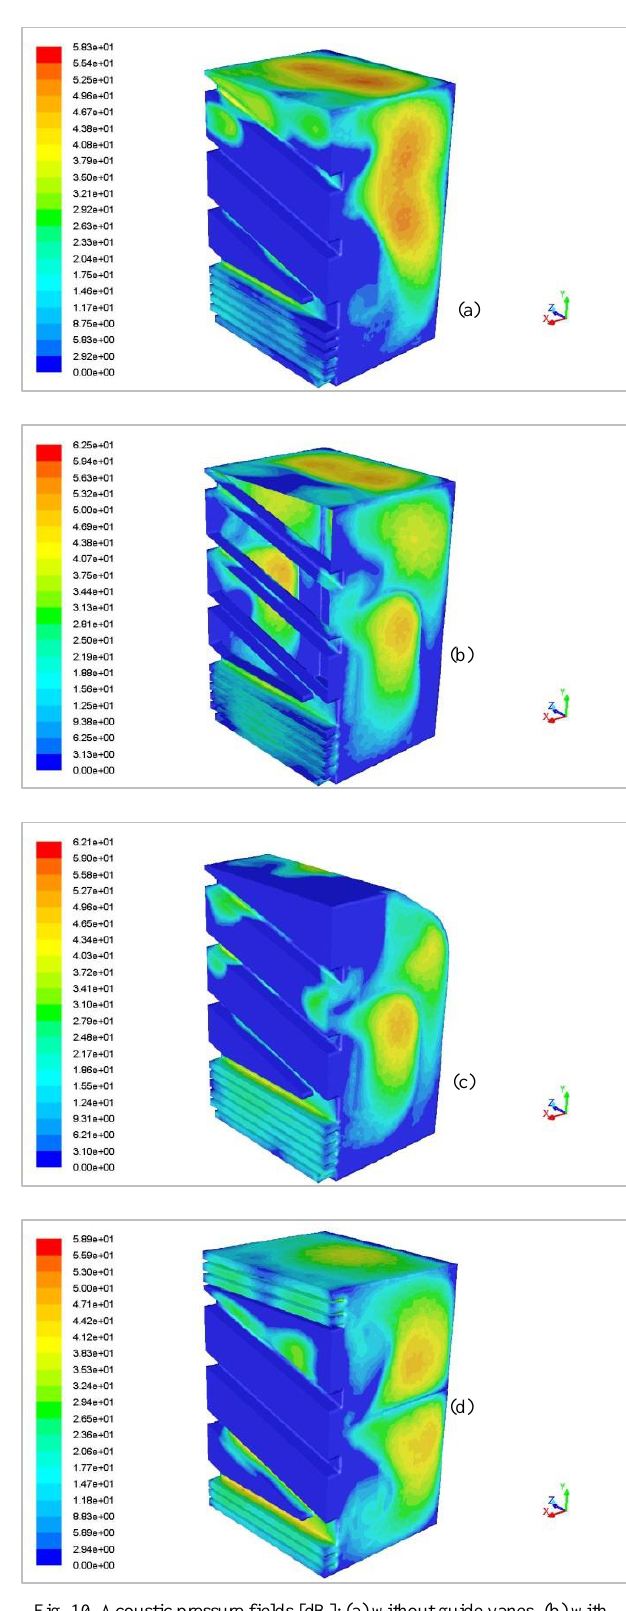
Fig. 9. Geometric models: (a) without guide vanes, (b) with one stream guide vane, (c) with two stream guide vanes, (d) with stream separation. The changes in geometry are indicated by arrows